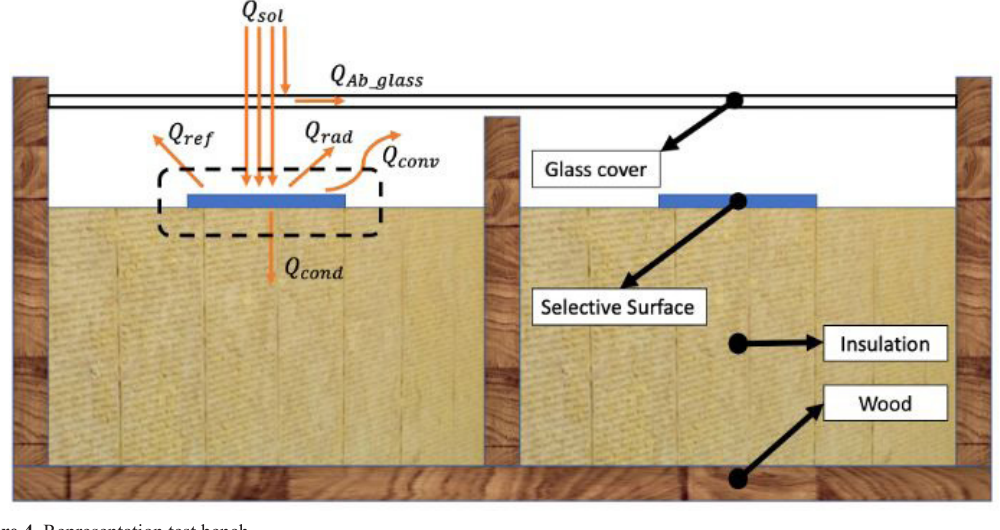
Figure 4. Representation test